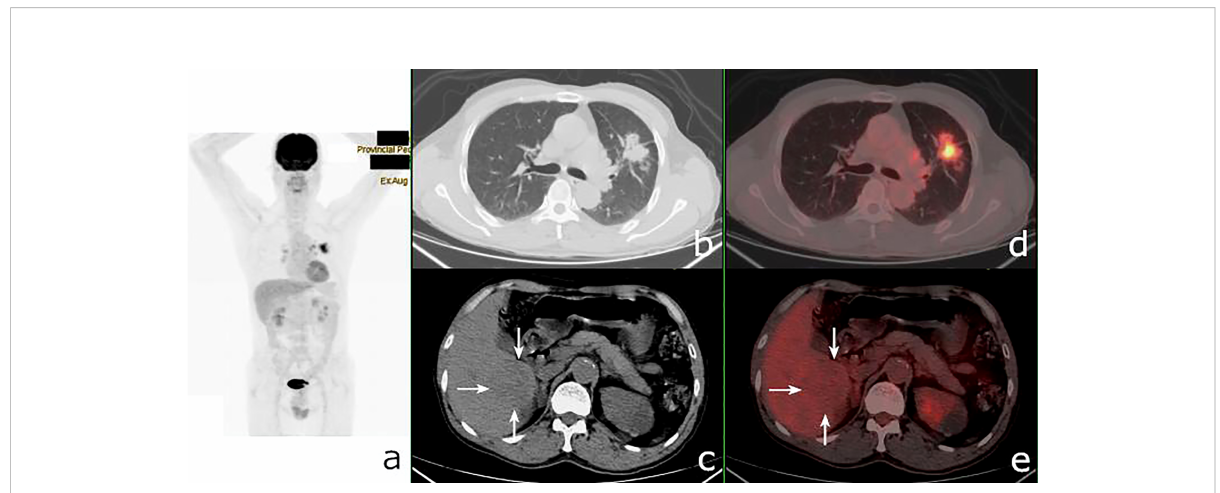
FIGURE 3 18 F- fl uorodeoxyglucose positron emission tomography/computed tomography ( 18 F-FDG PET/CT) of a 62-year-old man with lung adenocarcinoma and hepatocellular carcinoma. PET/CT revealed a lobulated mass with central FDG uptake (maximum standardized uptake value, SUV max = 8.9) and a 48 × 49-mm hypodense mass with SUV max = 2.0 in the right hepatic lobe ( white arrows ). (A) : PET maximum maximum intensity projection (MIP). (B, C) : Axial CT. (D, E) Fusion images.